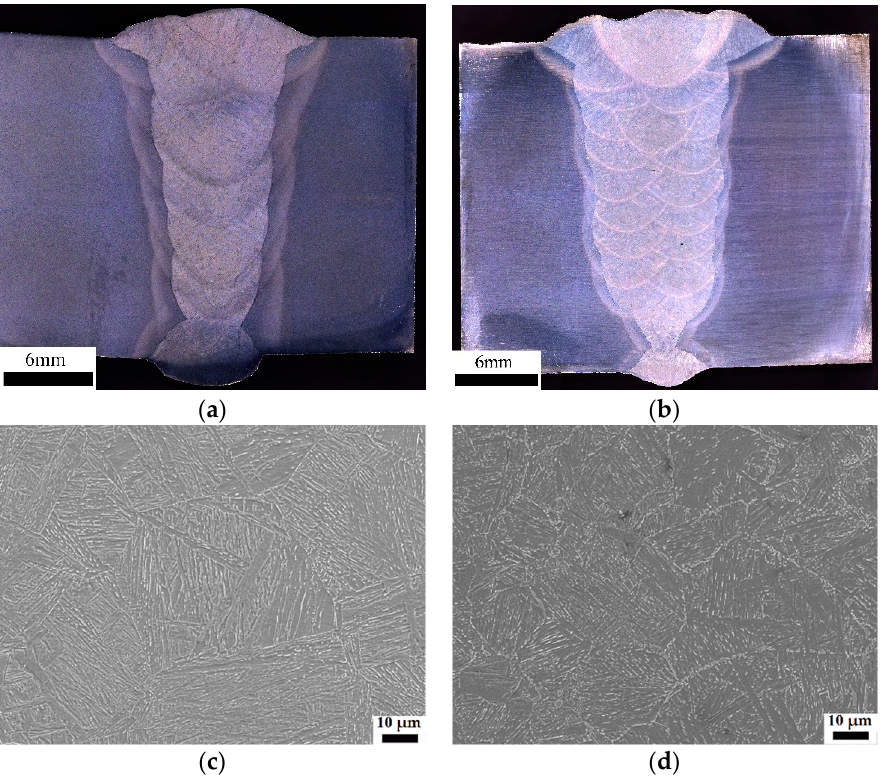
Figure 2. Macro-morphology of girth welded joints and microstructure of CGHAZs with different heat inputs: ( a , c ) conventional heat input; ( b , d ) ultra-low heat input.